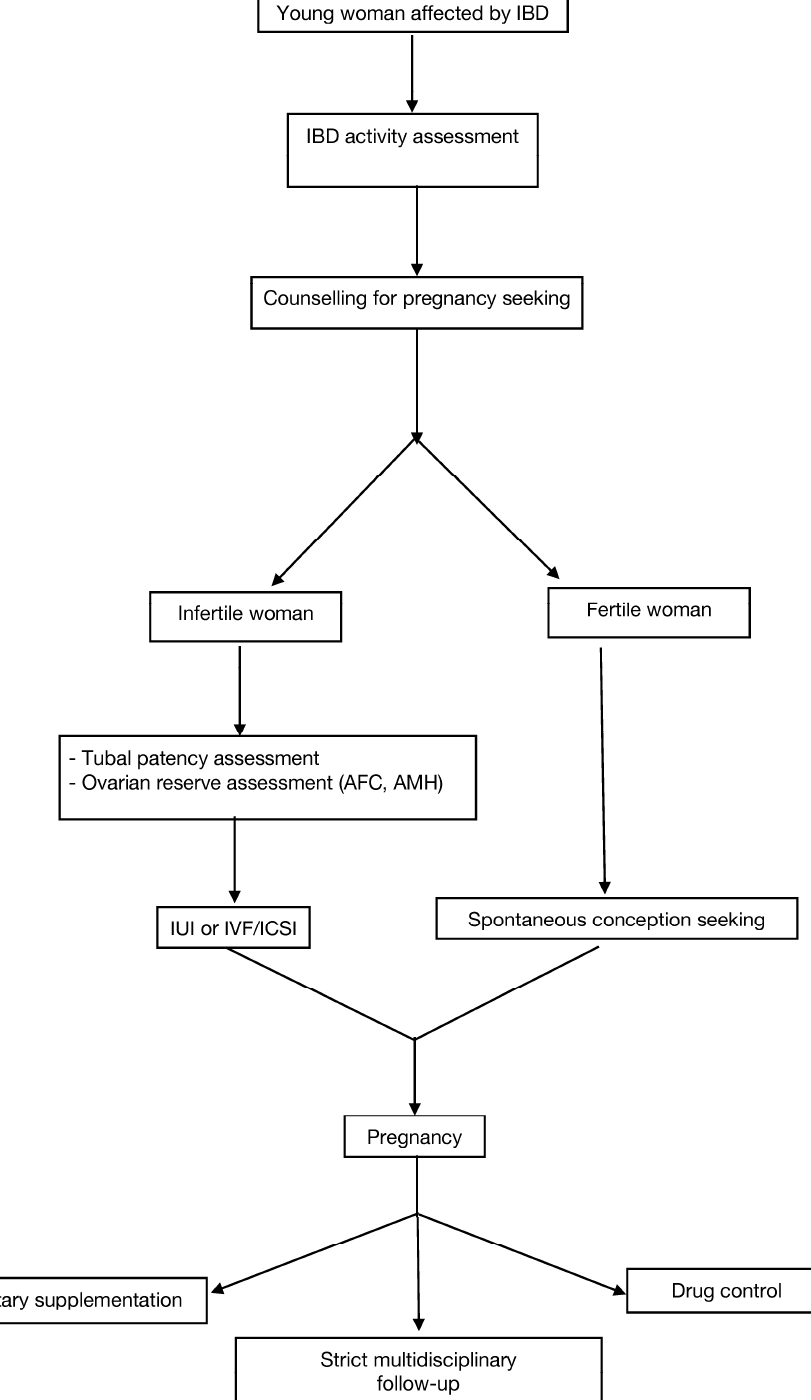
Figure 1. Management flowchart for young women affected by Inflammatory Bowel Disease at reproductive age (IBD: Inflammatory Bowel Disease; AFC: Antral follicular count; AMH: Anti- Mullerian Hormone; IUI: Intrauterine Insemination; IVF: In Vitro Fertilization; ICSI: Intracytoplasmic Sperm Injection).